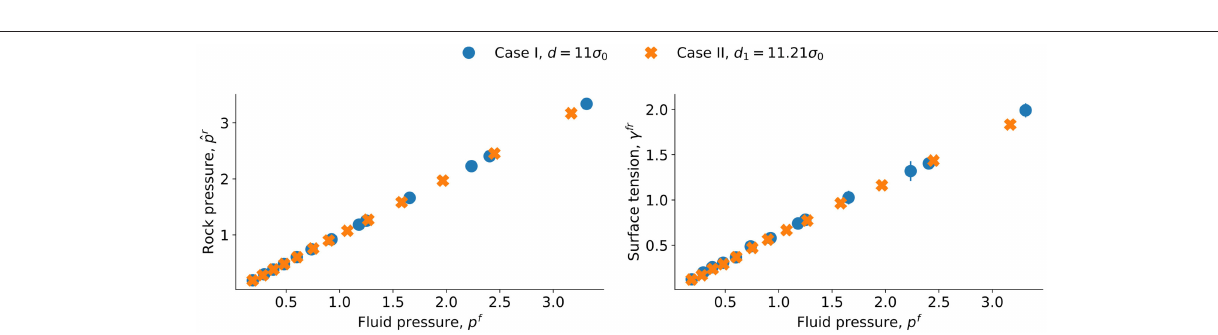
11 σ 0 ) and a lattice of spheres =